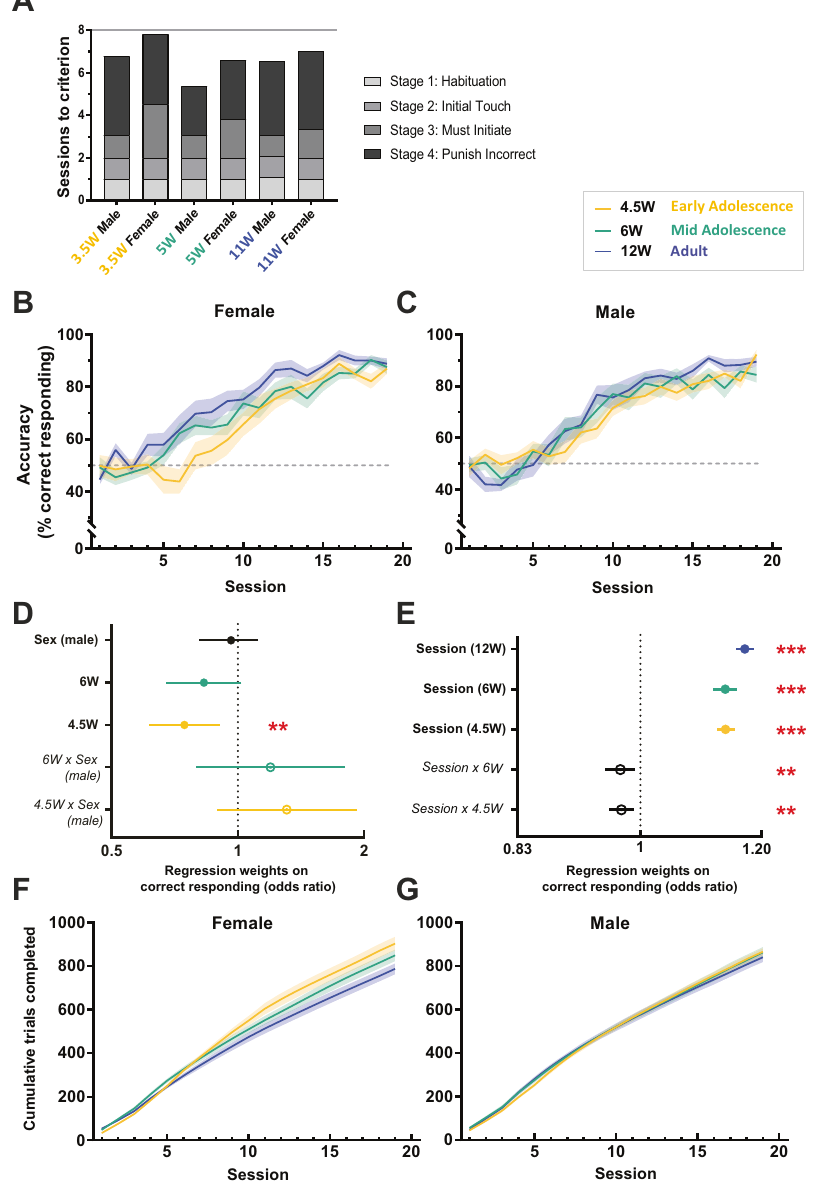
Stage1:Habituation Stage2:InitialTouch Stage3:MustInitiate Stage4:PunishIncorrect